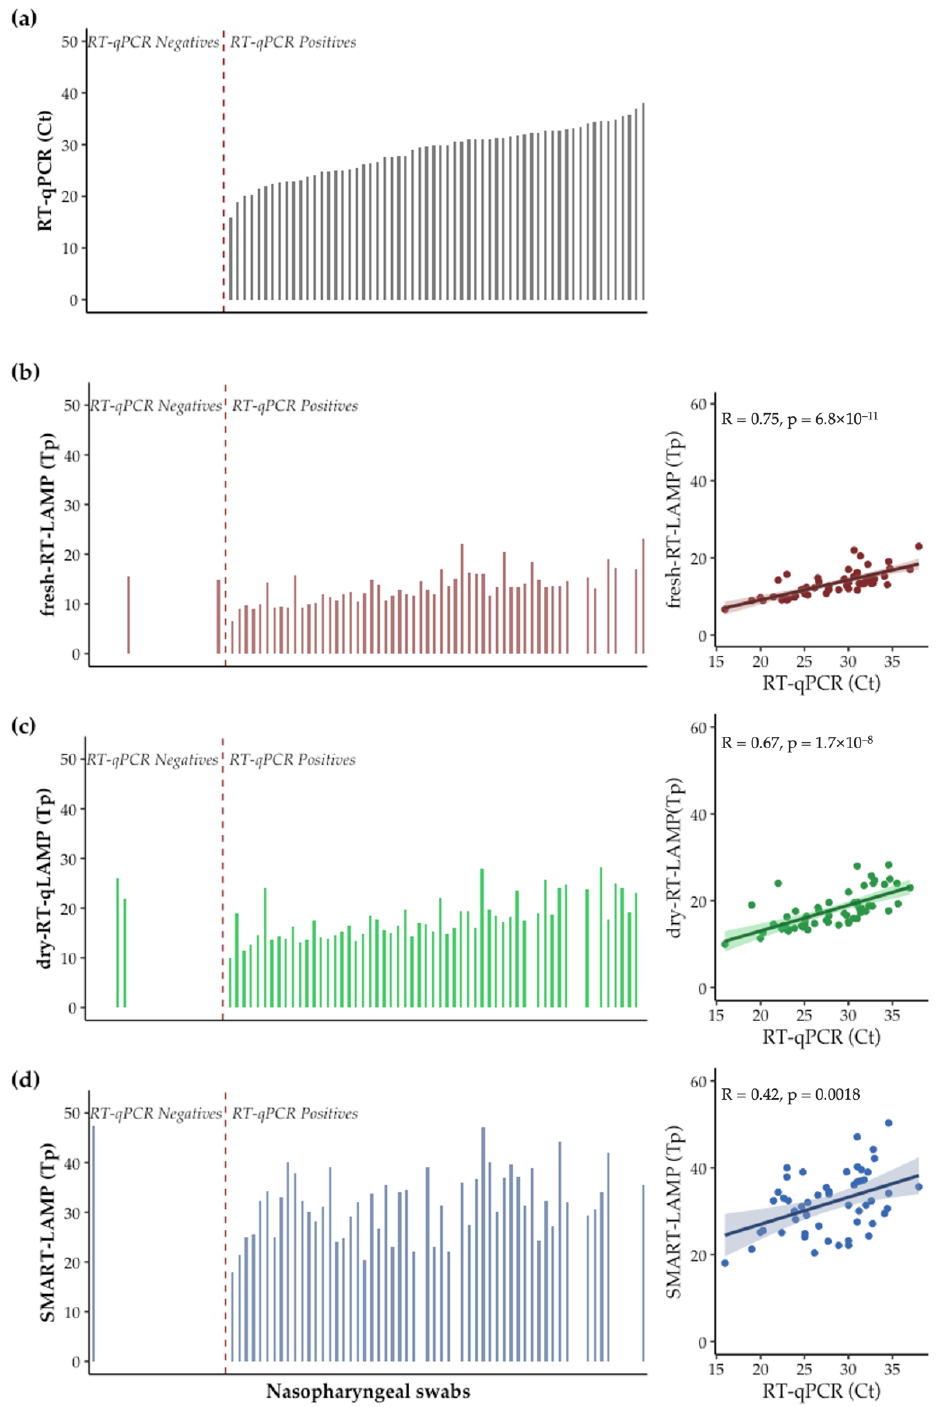
Figure 6. Analysis of RNA samples from patients suspected of having COVID-19. On the left panels, results from the analysis of the 80 samples are shown ordered from low to high RT-qPCR Ct values obtained. On the right panels, correlation plots between Ct and Tp values in RT-qPCR and LAMP assays, respectively, are represented. R and p values obtained by Pearson’s correlation are shown in each graph: ( a ) RT-qPCR Ct values of the 80 samples analyzed; ( b ) Fresh-RT-qLAMP Tp values of the 80 analyzed samples and their correlation with RT-qPCR results; ( c ) Dry-RT-qLAMP Tp values of the 80 analyzed samples and their correlation with RT-qPCR results; ( d ) SMART-LAMP Tp values of the 80 samples analyzed and their correlation with RT-qPCR results.